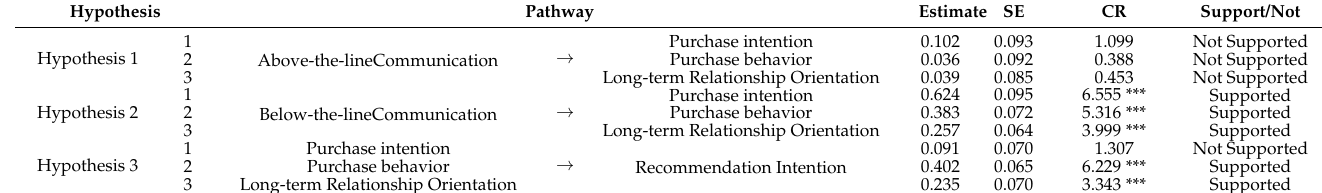
Table 5. Verification result of all hypotheses proposed in this study.